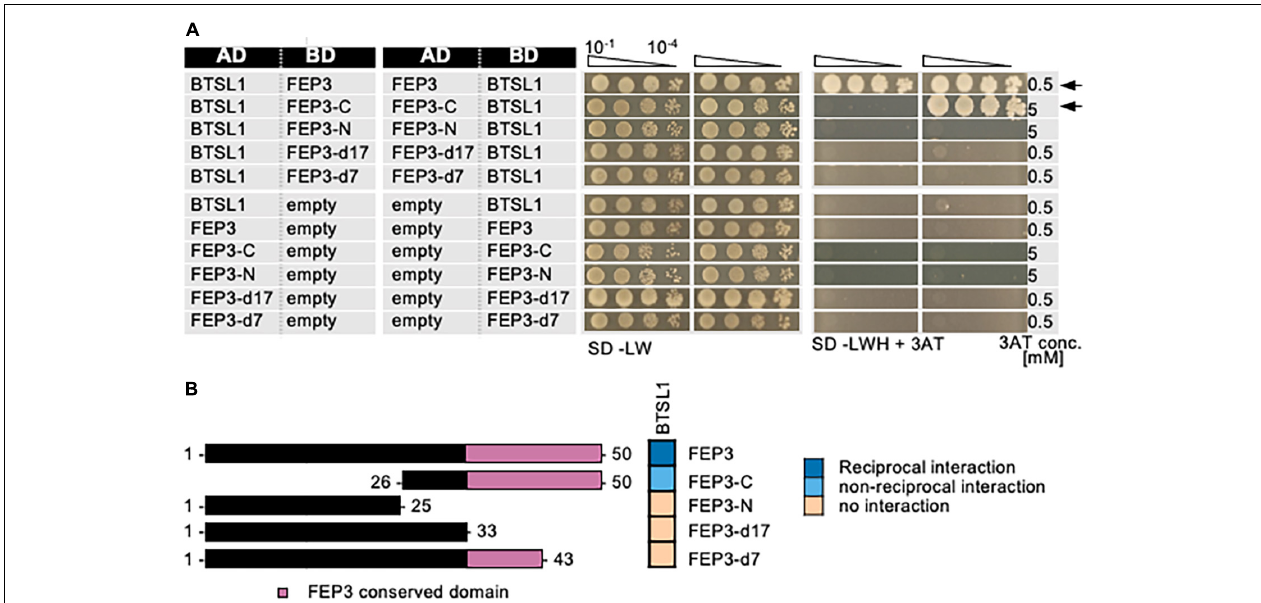
FIGURE 5 | Mapping of the interaction site in FEP3/IMA1 by yeast two hybrid (Y2H) assays. (A) Targeted deletion forms of FEP3/IMA1 were tested in reciprocal targeted Y2H assays against BTSL1. Yeast co-transformed with the AD and BD combinations were spotted in 10-fold dilution series (A 600 = 10 − 1 –10 − 4 ) on SD-LW (transformation control) and SD-LWH plates supplemented with different 3AT concentrations (conc.) as indicated (selection for protein interaction). Negative controls: empty vectors. Arrows indicate interaction. (B) Schematic representation and summary of Y2H results. Left, schematic representation of FEP3 and deletion constructs, used for Y2H. Pink color illustrates the conserved region of FEP3 (see Supplementary Figure 5 ). Right, summary results of panel (A) . The color code distinguishes reciprocal positive interactions (dark blue), non-reciprocal positive interactions (light blue), negative results on interactions (light